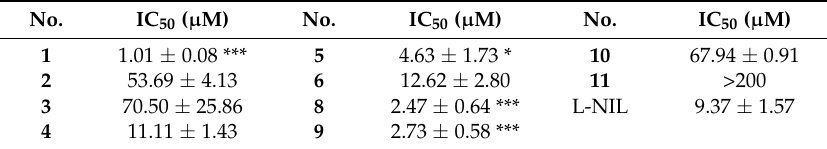
Table 3. Inhibition of compounds 1 – 9 on NO production ( n =